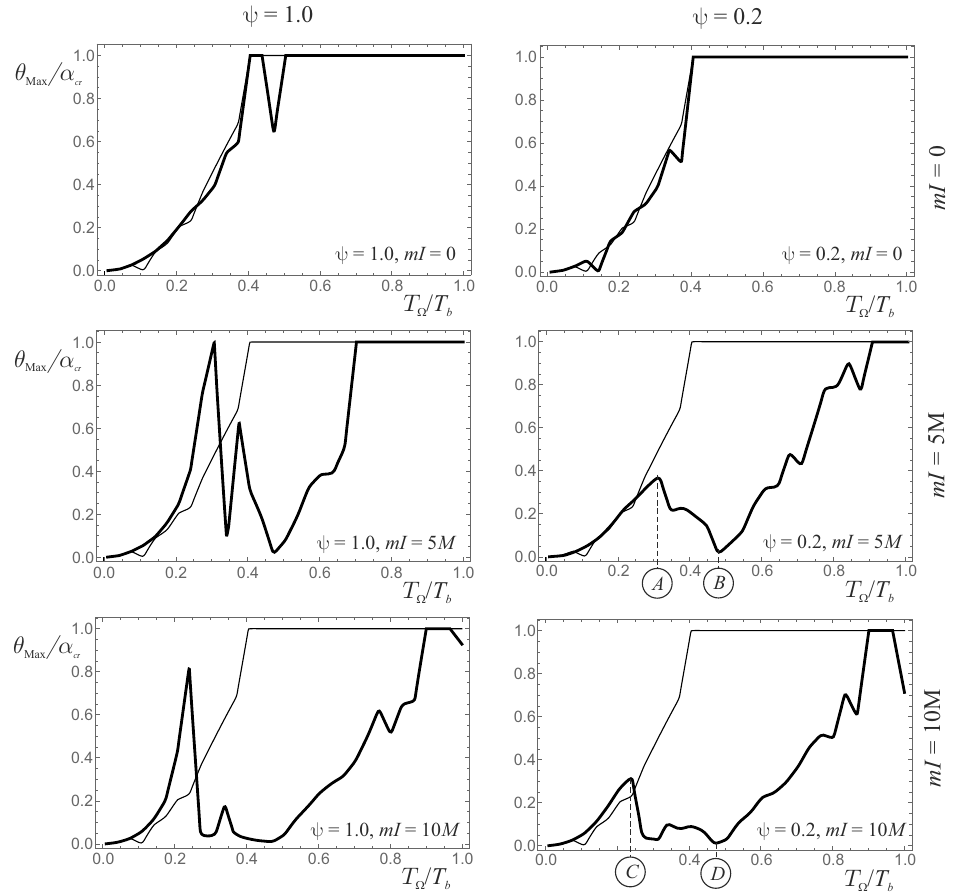
Figure 3. Frequency–response curves of coupled systems (thick lines) and stand-alone rigid blocks (thin lines) for different values of the post- to pre-yielding stiffness ratios ψ and different values of the apparent mass m I . Points A–D: points used in further analyses. Dimensions of the rigid block: 2 b = 0.6 m and λ = 5 ( r = 0.9423, T aux = 0.5 T b , u y = 1/3 u cr , m = 0.05 M